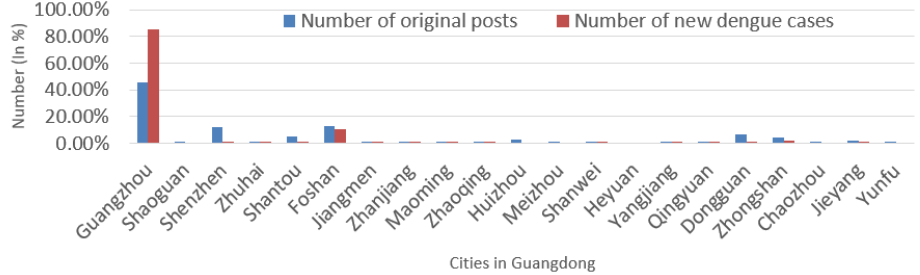
Figure 3. The number of original posts and new dengue fever cases reported on 22 September 2014.